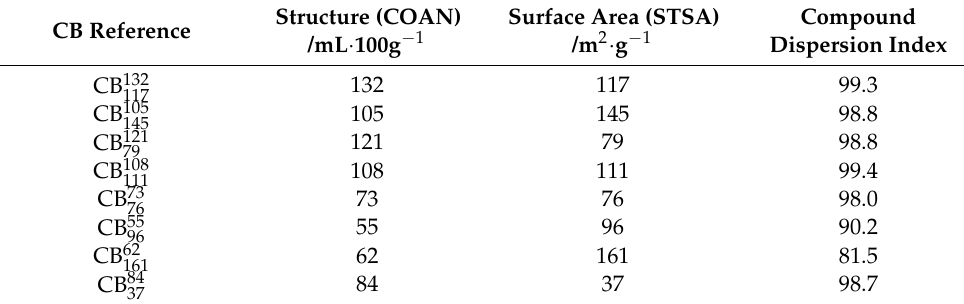
Table 2. Naming convention of CBs; colloidal properties; dispersion indices. Structure (COAN) CB Reference /mL · 100g −